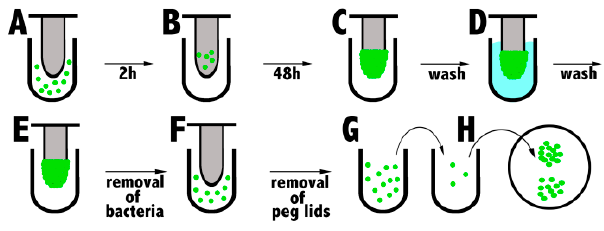
Figure 5. Diagram of experimental procedure for peg lid biofilm assay.